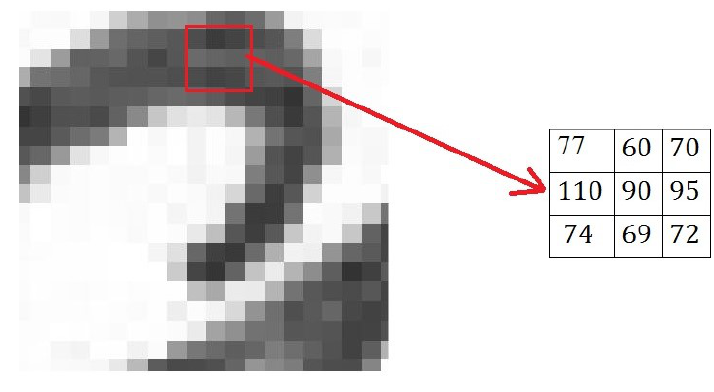
Figure 5. Magnified image of a stroke shows the variation in gray values. A 3 × 3 matrix shows the intensity values of the gray image segment marked in